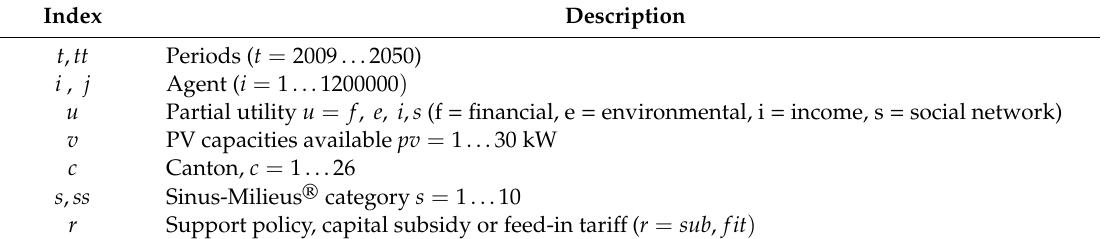
Table A8. Indices used in the mathematical description of the model.